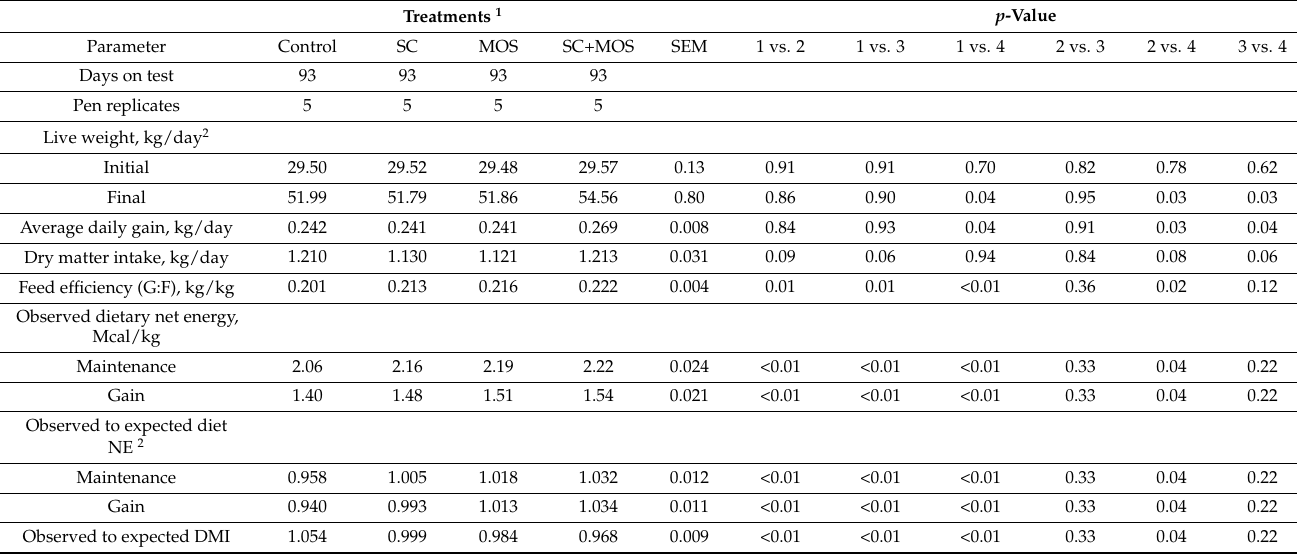
Table 3. Effect of treatments on growth performance and dietary energy utilization of finishing lambs supplemented for 93 days with eubiotics alone or